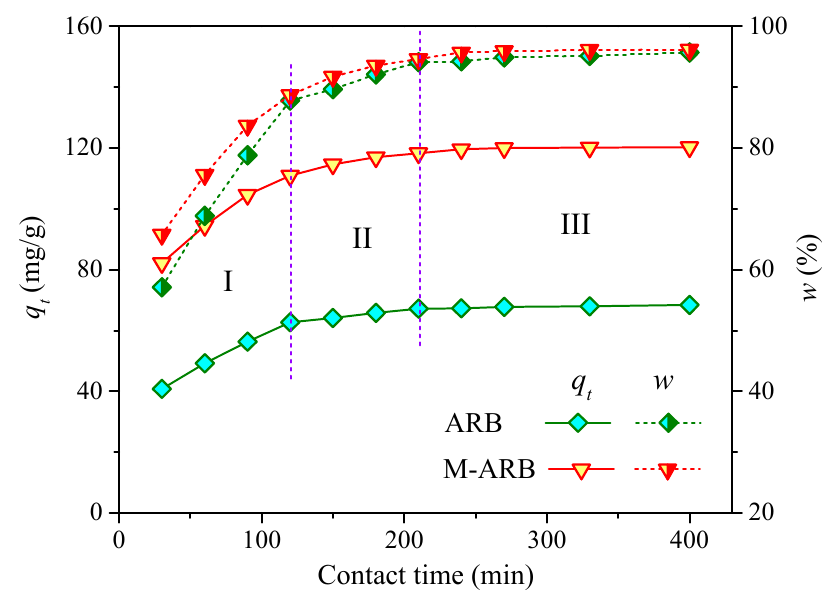
Figure 5. Effect of contact time on MB adsorption performance.